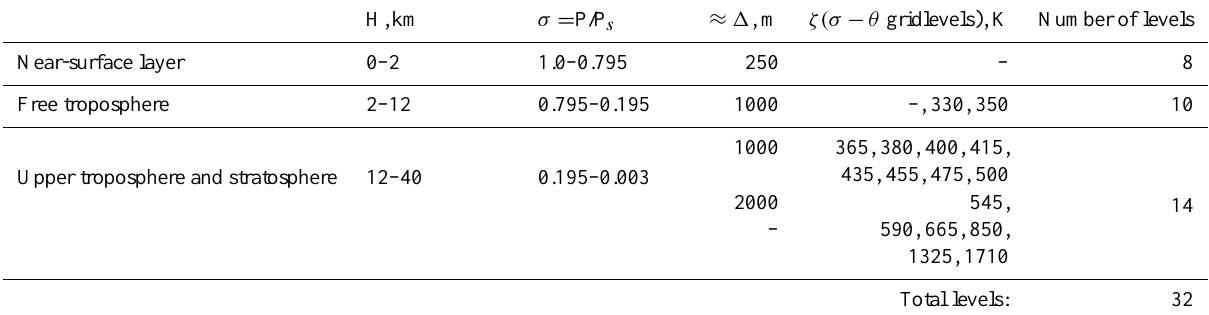
Table 1. Levels of the vertical grid in the NIES TM